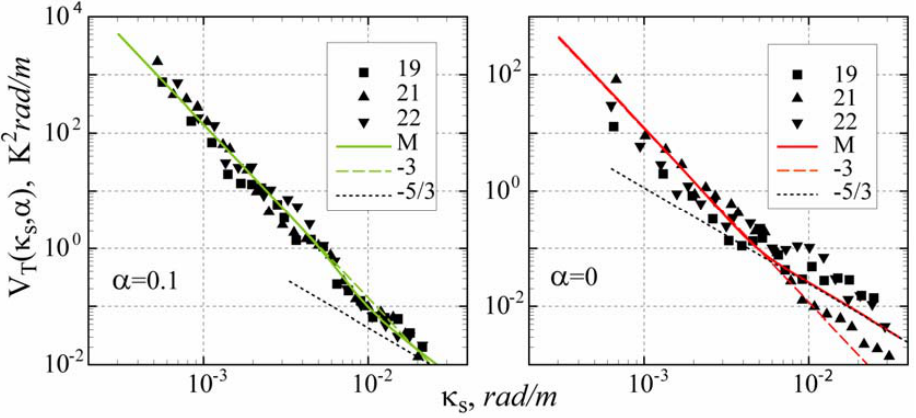
Fig. 4. Comparison of the model with the measurements of Gurvich and Kukharez (2008). Left panel is oblique spectra (α = 0 . 1 ) , right panel is horizontal (α = 0 ) spectra. M is model calculated by using Eq. (4), dot and dash lines is asymptotic power law, symbols are experimental estimations, 19–22 are flight days.